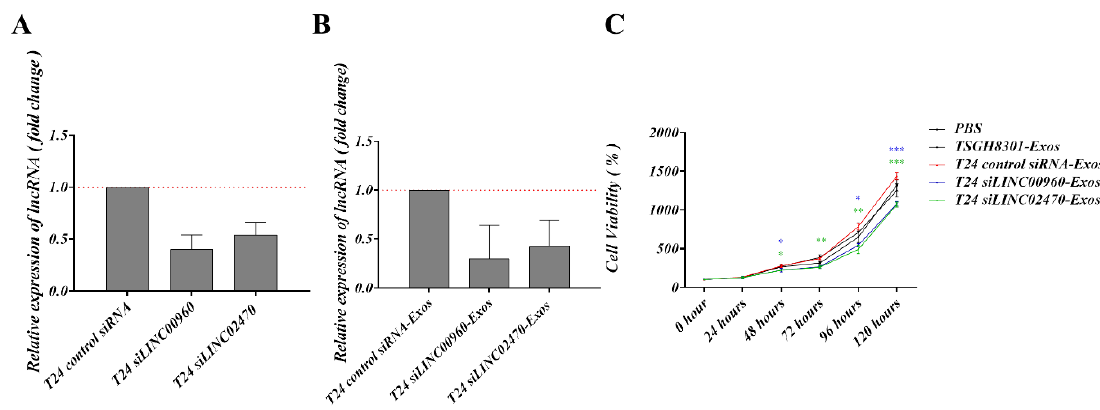
Figure 6. Exosomes derived from LINC00960-knockdown or LINC02470-knockdown T24 cell conferred less aggressiveness-inductive abilities in recipient TSGH-8301 cells. LINC00960 or LINC02470 expression levels were compared by RT-qPCR in ( A ) intracellular levels and ( B ) the exosomal levels. ( C ) Cell growth curve was compared using MTT assays in TSGH-8301 cell treated with each exosome. The quantitative results are shown as the bar-charts or growth curves for mean and SD of triplicate experiments, * p < 0.05, ** p < 0.01, *** p < 0.001.